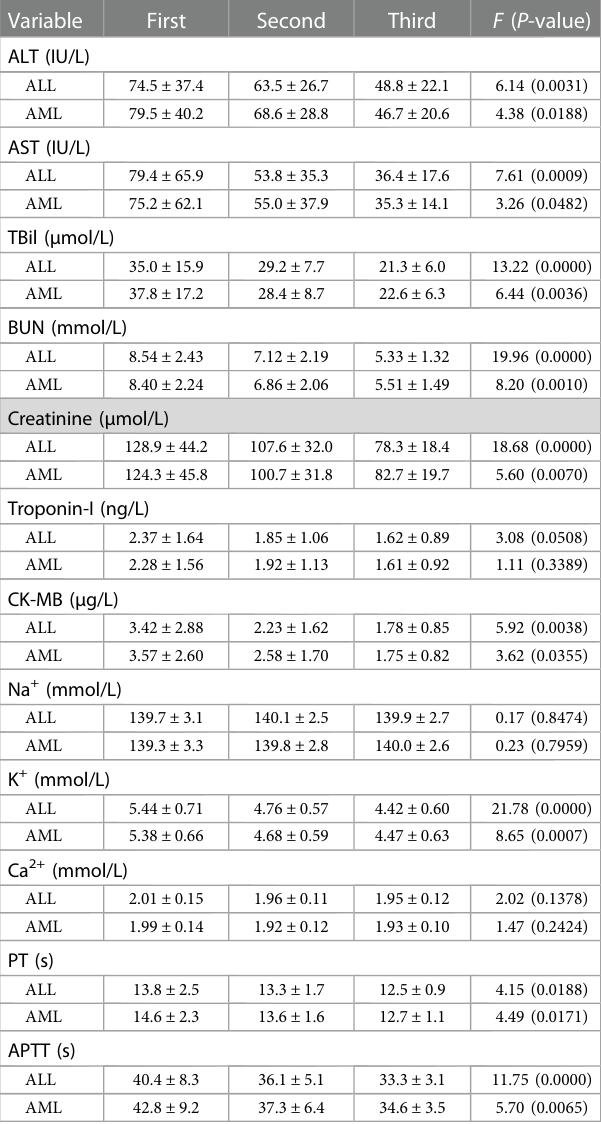
TABLE 2 Three assessments of blood biochemistry, electrolytes, and coagulation function in ALL and AML patients. Variable